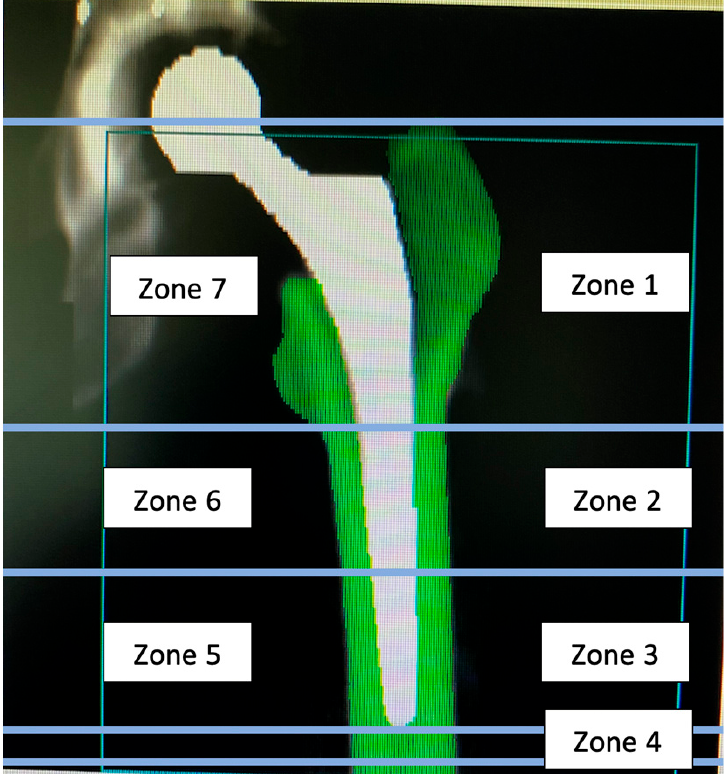
Figure 1. DEXA scan of Gruen zones at 4 and 8 weeks postoperatively.